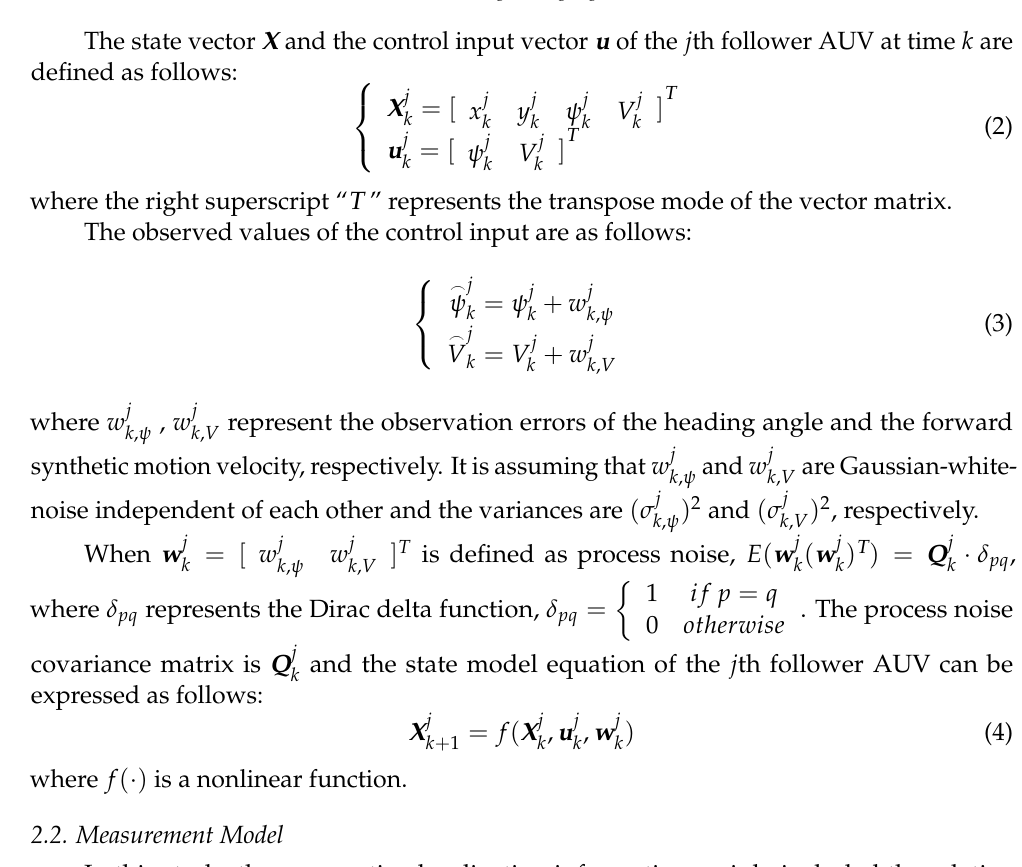
Figure 1. Schematic diagram of a multi-AUV cooperative localization system. ( a ) Description of the projection of the leader AUV in the O g − X g Y g Z g coordinate system with respect to the O g (cid:48) − X g (cid:48) Y g (cid:48) horizontal plane in the O g (cid:48) − X g (cid:48) Y g (cid:48) Z g (cid:48) coordinate system; ( b ) description of the relative position of the leader AUV and the follower AUV in the O g (cid:48) − X g (cid:48) Y g (cid:48) horizontal